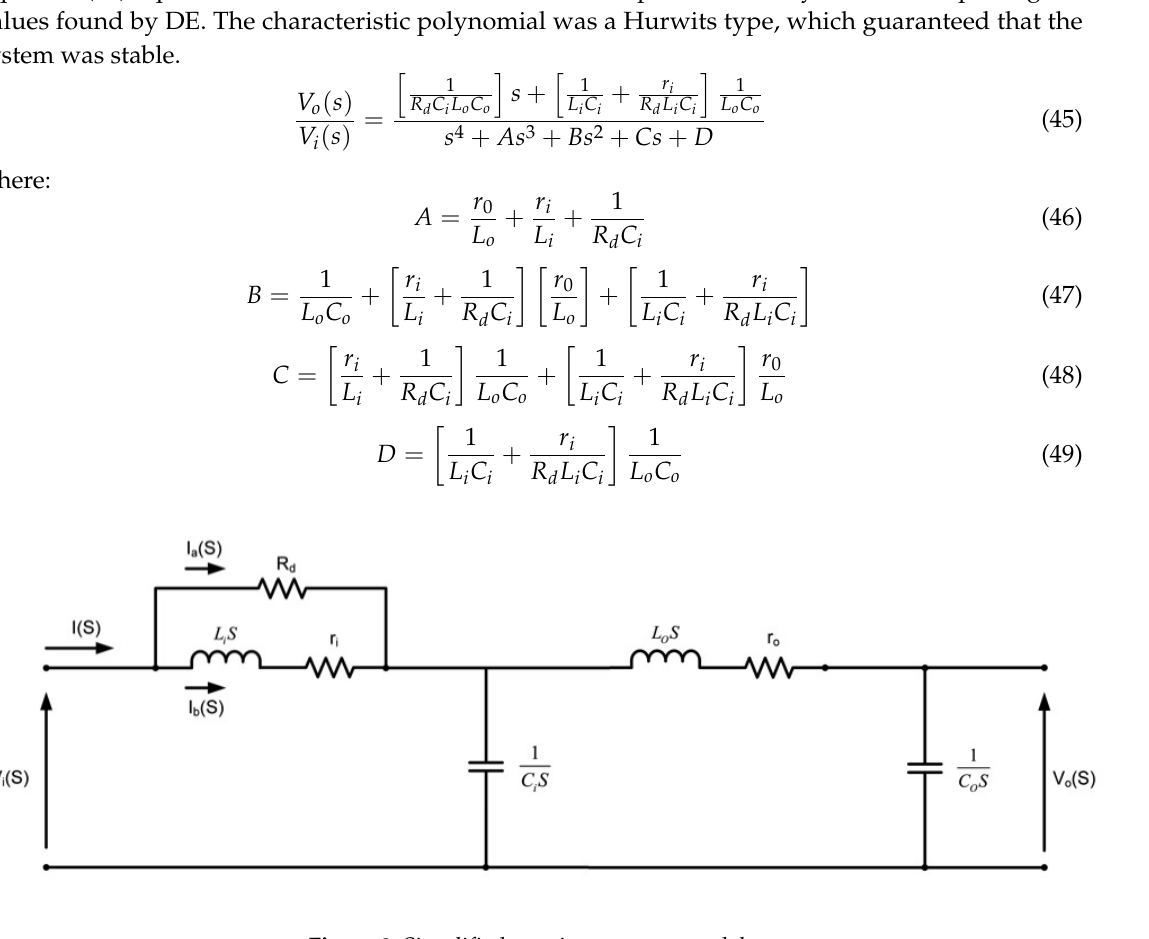
Figure 8. Simplified matrix converter